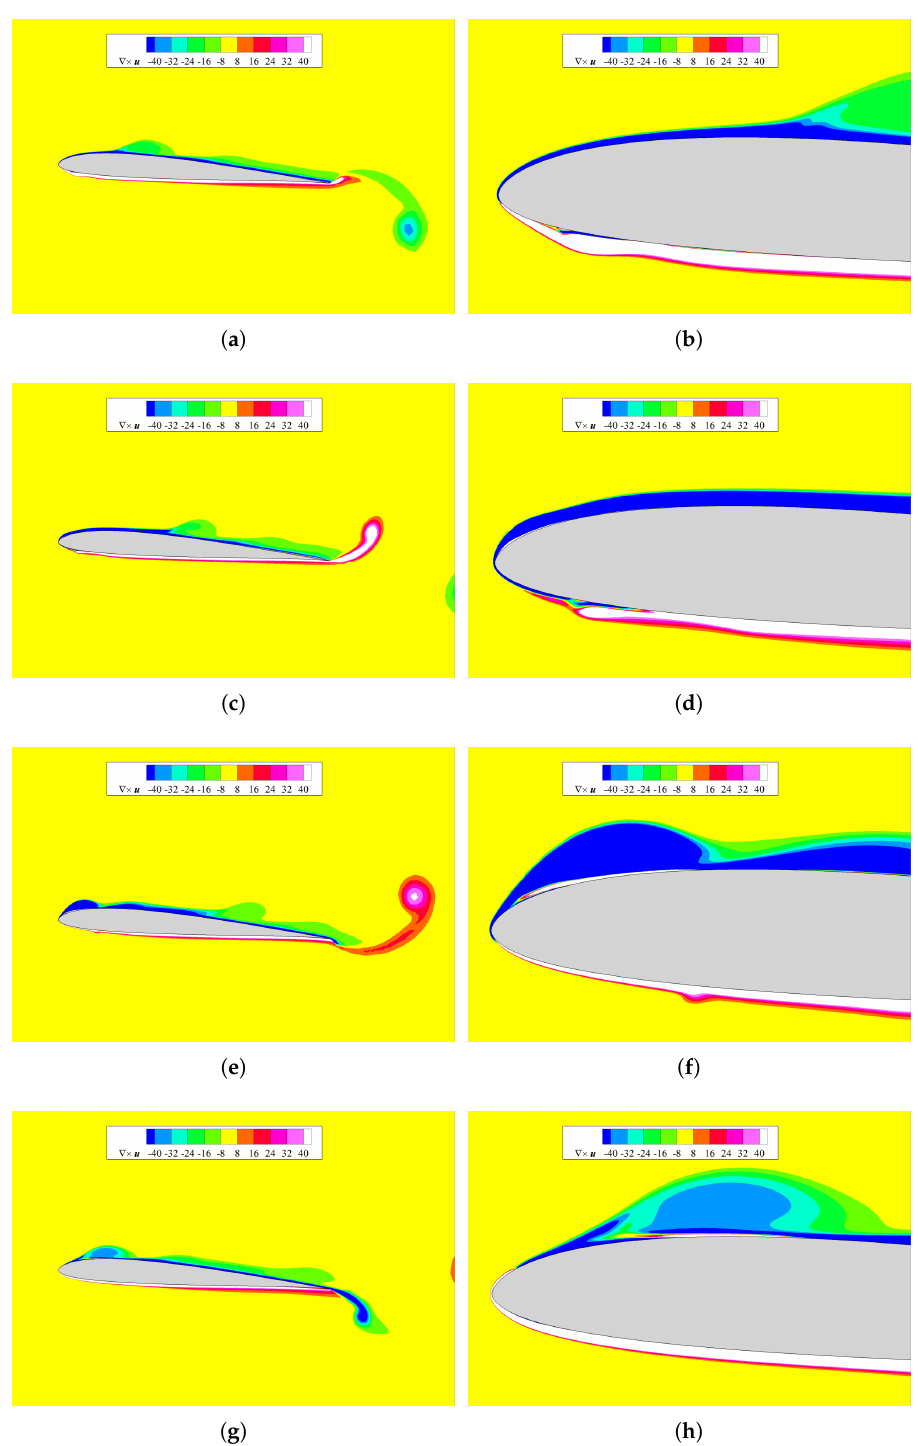
Figure 10. SA model. Contour of instantaneous spanwise vorticity. From top to bottom, the vertical positions are presented in the sequence: ( a , b ) Φ = 0; ( c , d ) Φ = 0.25; ( e , f ) Φ = 0.5; ( g , h ) Φ = 0.75. The right column reports the details of the instability developing at leading